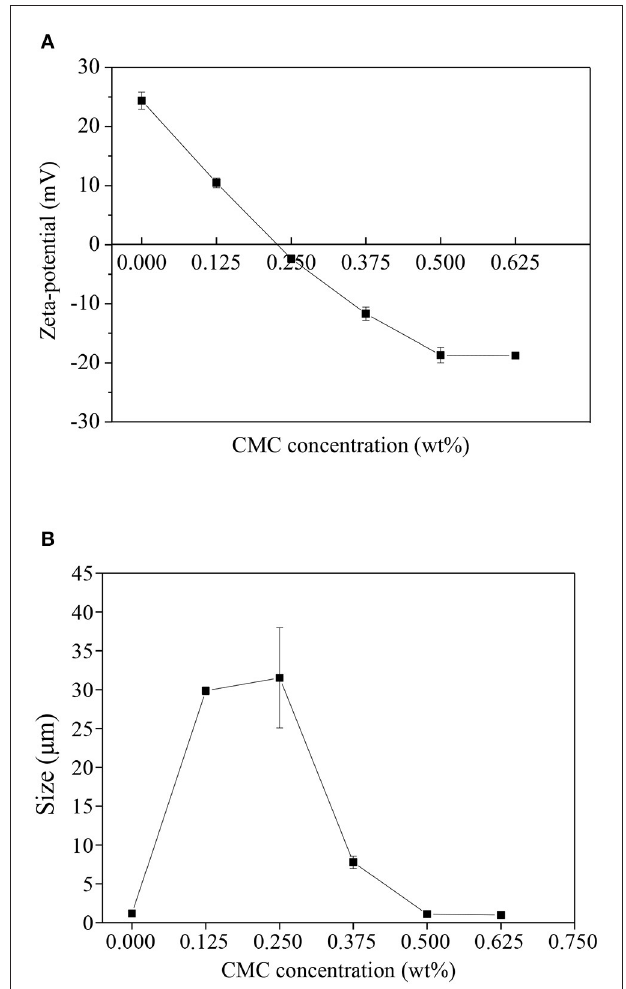
FIGURE 1 | Effect of the different concentrations of carboxymethyl cellulose (CMC) on the zeta potential (A,B) particle size of SPI (1 wt%) stabilized rice bran oil (RBO) (6.67 wt%) emulsions at pH 3.5, 25 ◦ C. Error bars are SDs of mean